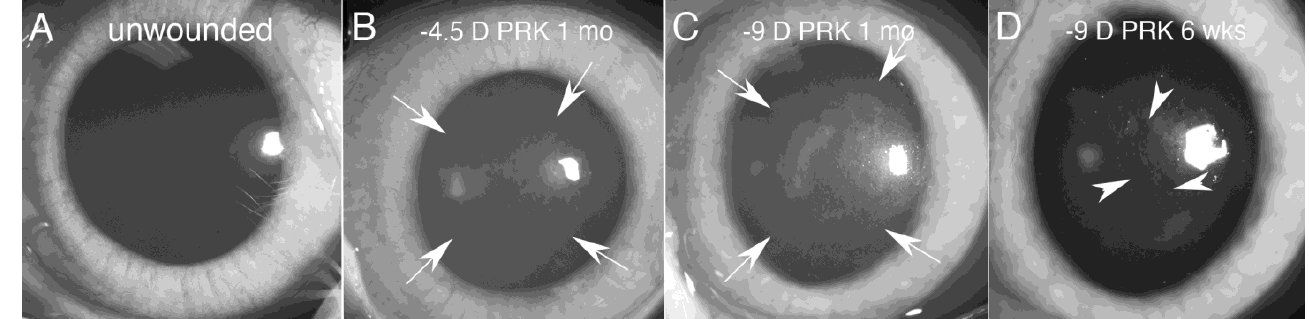
Figure 1. Slit lamp images of rabbit corneas. ( A ) The unwounded cornea is transparent. ( B ) At one month after − 4.5 diopter (low myopia correction) PRK (photorefractive keratectomy) there was mild opacity (haze) of the cornea (within arrows). Corneal fibroblasts but no myofibroblasts were present in this cornea with immunohistochemistry (IHC) analysis. ( C ) At one month after − 9 diopter (high myopia correction) PRK, there was moderate opacity (haze) of the cornea (within arrows). Myofi- broblasts and corneal fibroblasts were now present in the anterior stroma (see Figure 3). ( D ) At six weeks after − 9 diopter (high myopia correction) PRK, clear areas referred to as “lacunae” (arrowheads) developed in the moderate opacity where the EBM had fully regenerated and myofibroblasts had undergone apoptosis. Over time, these lacunae will become more numerous, enlarge, and coalesce, until complete transparency is restored to the cornea. Mag 15 ×